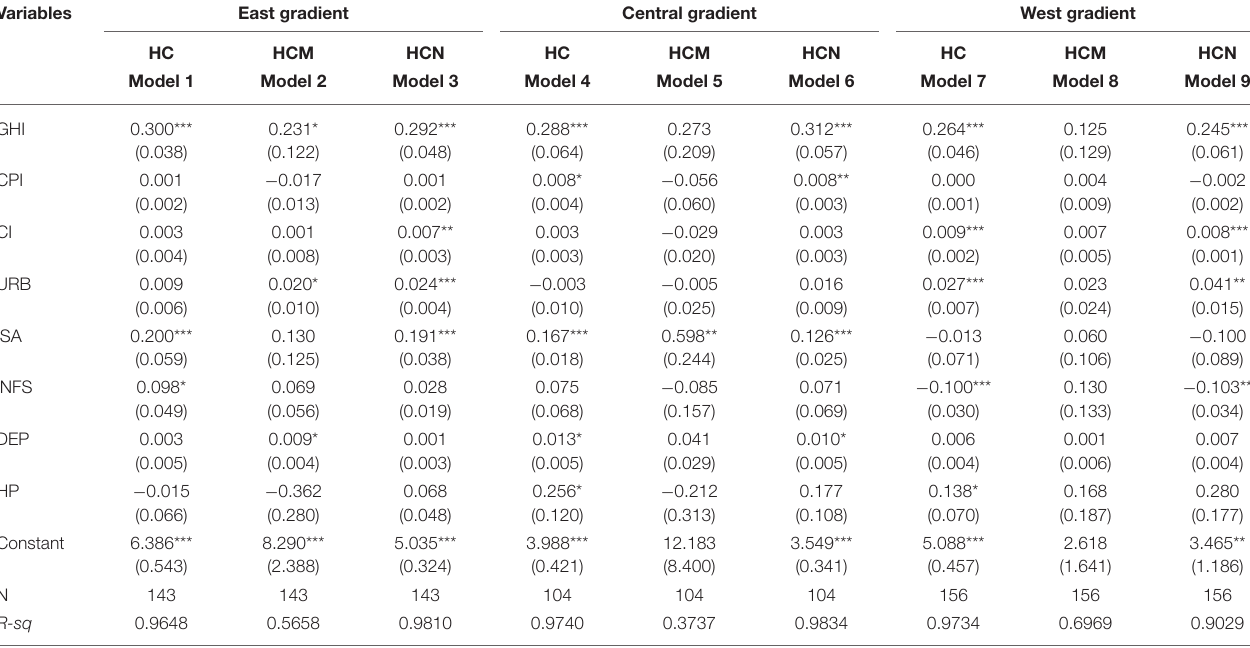
TABLE 6 | Heterogeneity analysis of different economic gradients